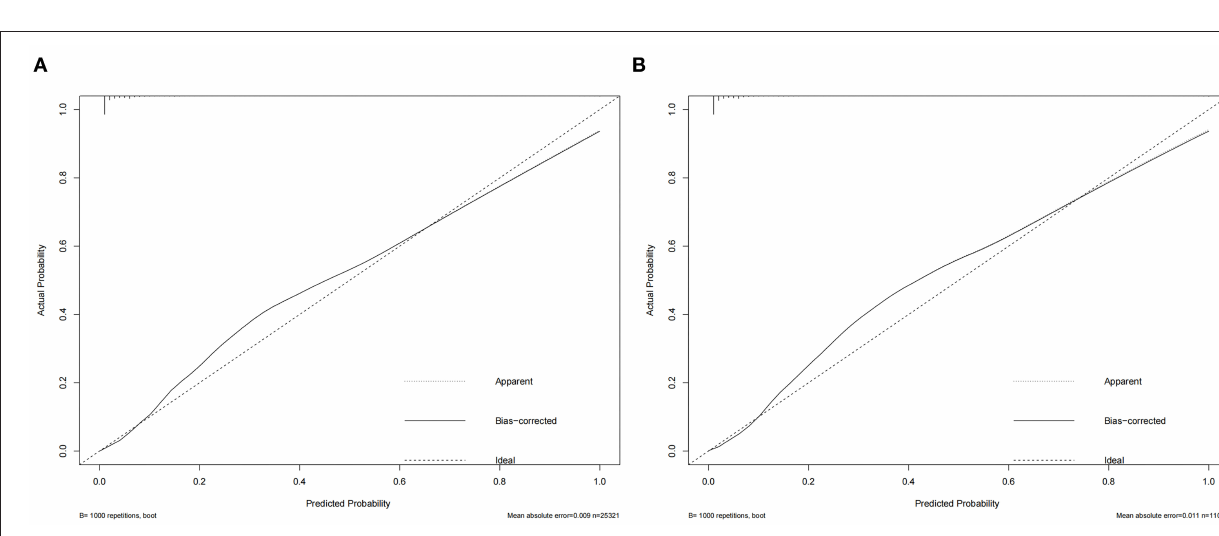
lymph node metastasis, with an accuracy of 78.4%. Capitanio et al. (28) also established a prediction model to predict lymph node metastasis in RCC patients, with an accuracy of